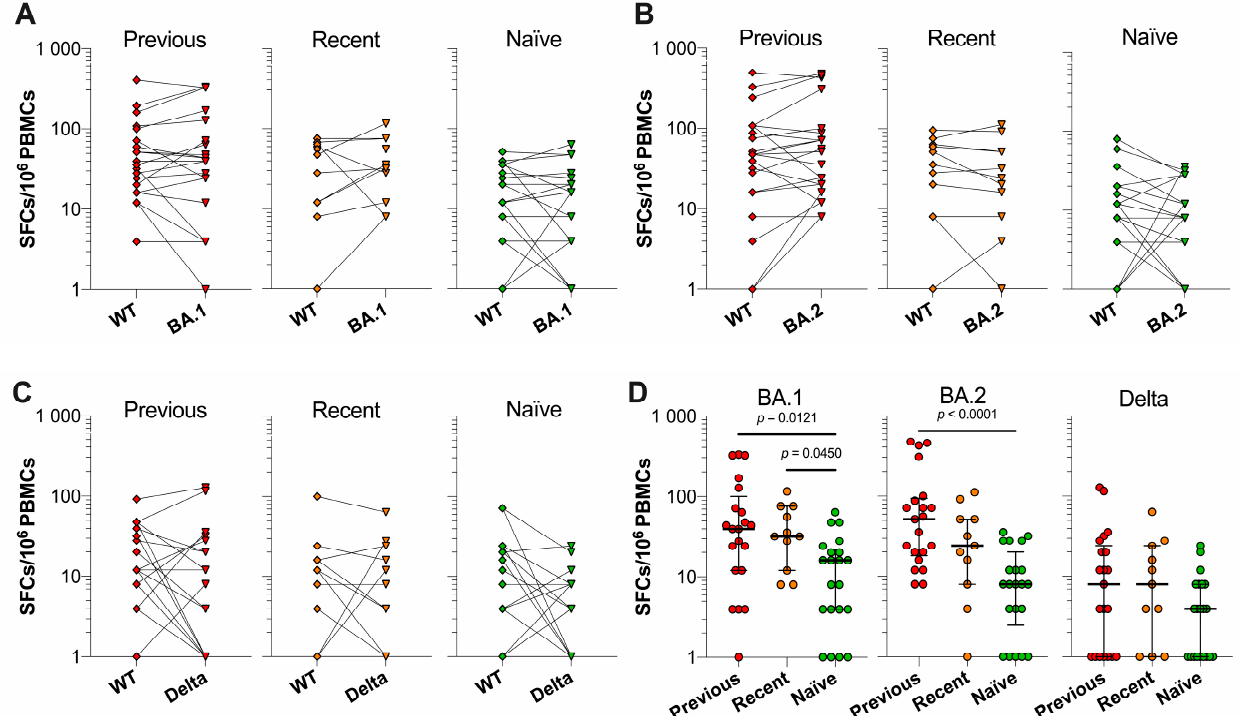
Figure 6. T cell responses against wild-type spike and VOC-mutated spike proteins. At t3, the PBMCs of previously infected ( n = 21), recently infected ( n = 11), and infection-naïve ( n = 21) HCWs were stimulated with SARS-CoV-2 Omicron BA.1, Omicron BA.2, and Delta mutation spike peptide pools and corresponding SARS-CoV-2 wildtype (WT) spike peptide pools. ( A ) T cell responses against the SARS-CoV-2 Omicron BA.1 spike and corresponding WT spike peptide pools. ( B ) T cell responses against the SARS-CoV-2 Omicron BA.2 spike and corresponding WT spike peptide pools. ( C ) T cell responses against the SARS-CoV-2 Delta spike and corresponding WT spike peptide pools. Statistical significance was assessed with a Mann–Whitney test. ( D ) T cell responses against SARS-CoV-2 Omicron BA.1, Omicron BA.2, and Delta spike mutation peptide pools between previously infected, recently infected, and infection-naive HCWs. Indicated is the median with IQR and statistical significance was assessed through a Kruskal–Wallis test with Dunn’s multiple comparison